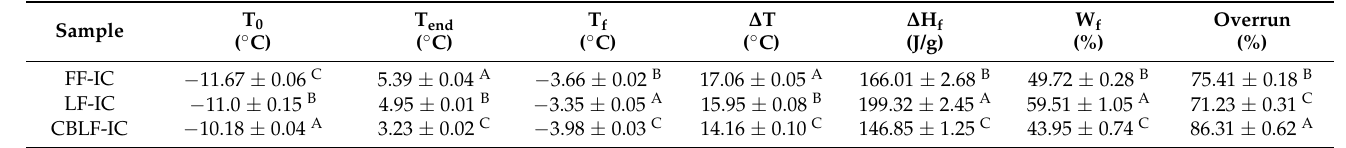
FF-IC: full-fat ice cream, LF-IC: low-fat ice cream, CBLF-IC: low-fat ice cream with chia seed oil by-product. Different letters in the same column indicate a statistical difference ( p <